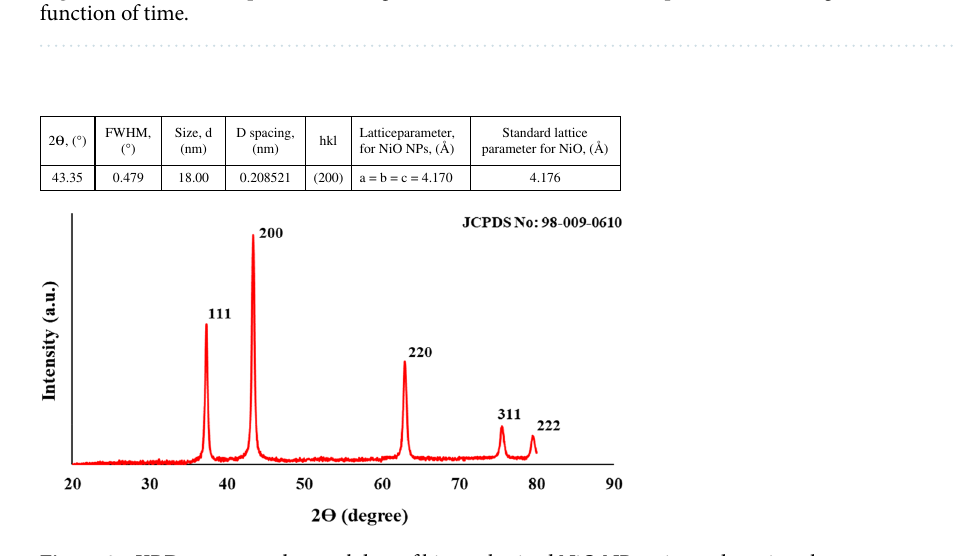
Figure 2. XRD pattern and crystal data of biosynthesized NiO NPs using red marine algae